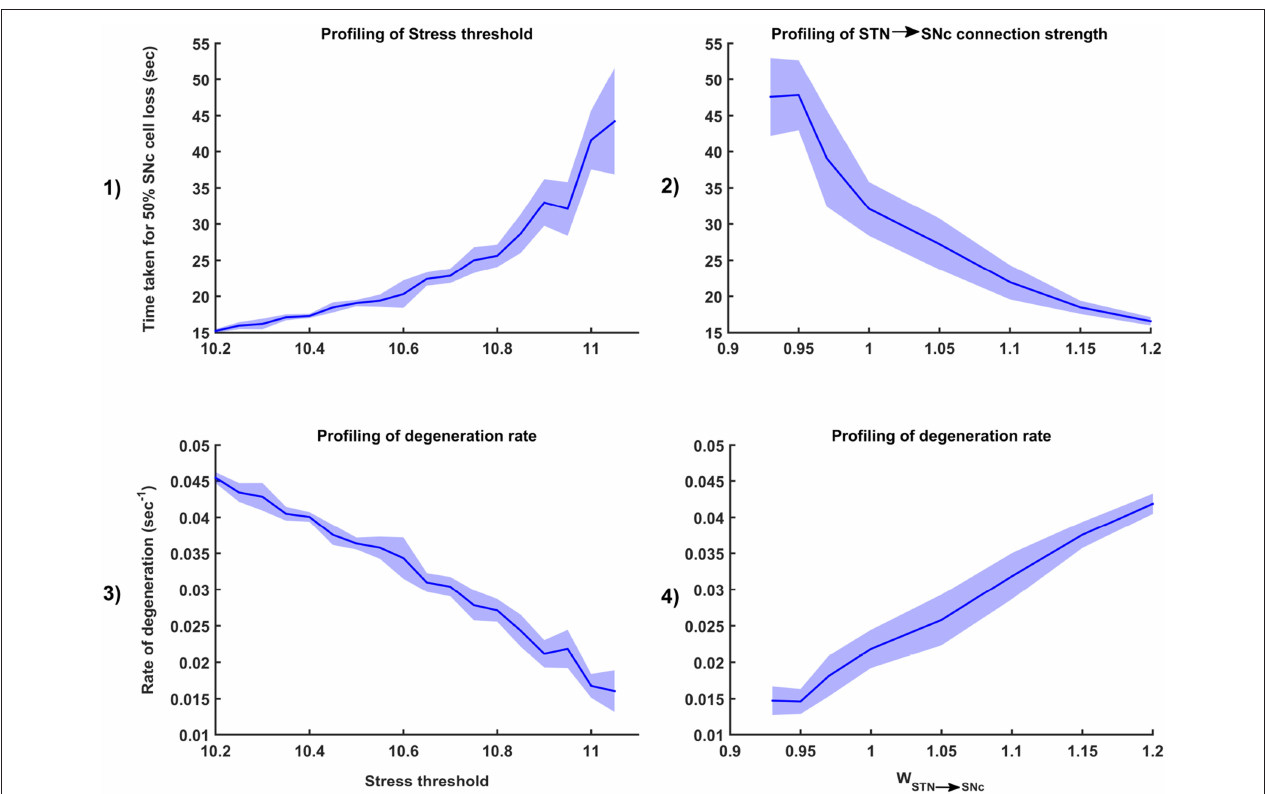
FIGURE 7 | Sensitivity of the proposed model toward parameter uncertainty. Time taken for 50% SNc cell loss for varying stress threshold ( Q thres ) (1) and connection strength from STN → SNc ( W STN → SNc ) (2) . Rate of degeneration ( λ ) for varying stress threshold ( Q thres ) (3) and connection strength from STN → SNc ( W STN → SNc ) (4) . STN, SubThalamic Nucleus; SNc, Substantia Nigra pars